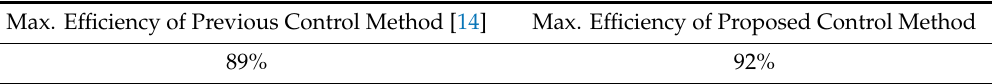
Table 3. Comparison of maximum e ffi ciency of the two